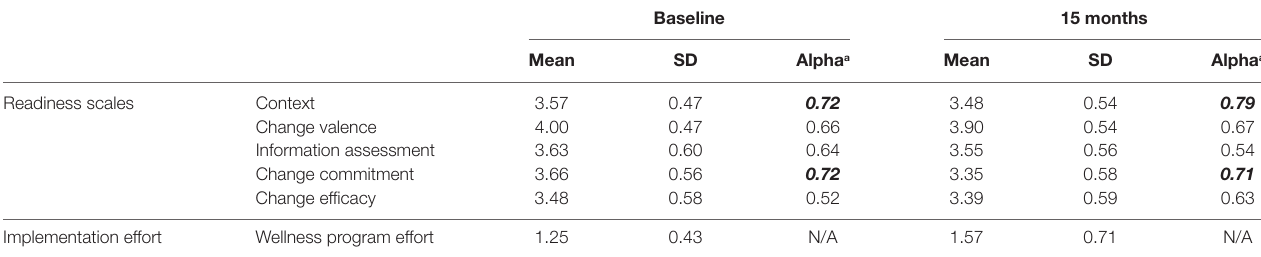
Table 3 | Organizational readiness to change scale means and reliabilities and means of Wellness Program Effort.